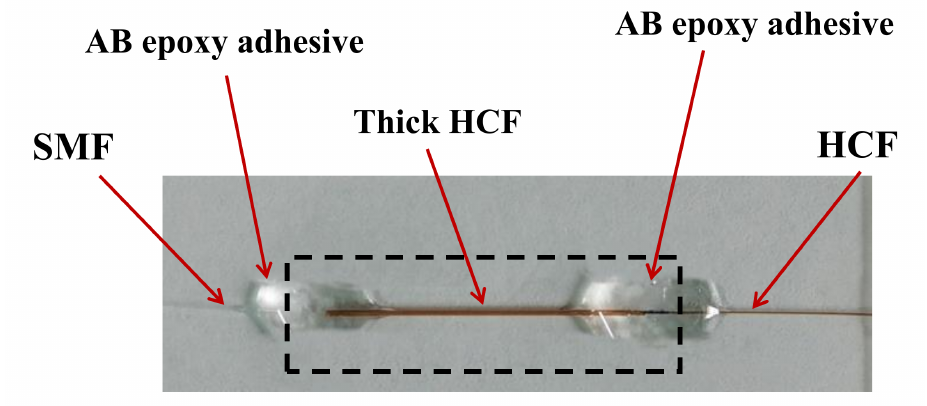
Figure 5. The picture of the packaged sensor structure.